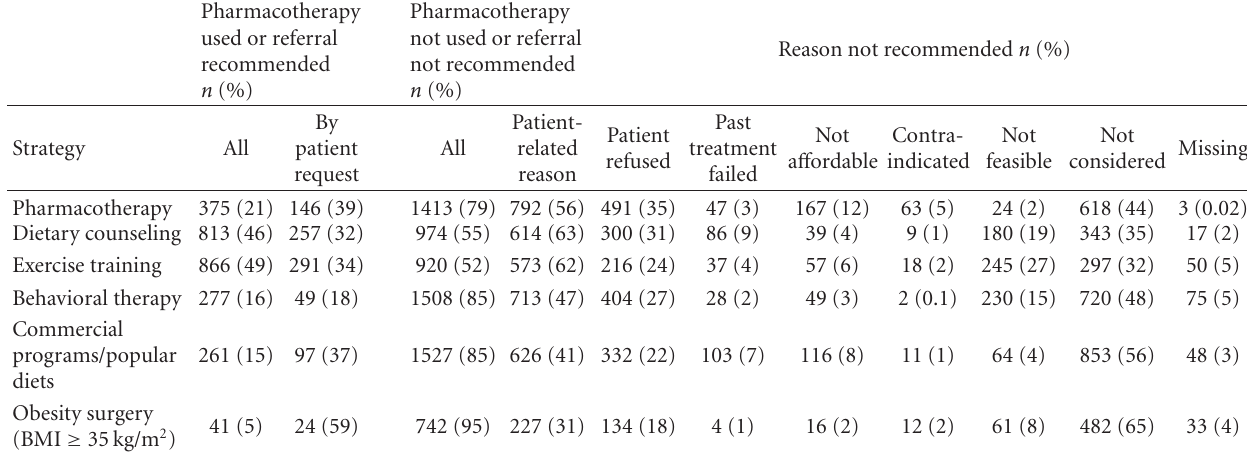
Table 2: Frequency of use of pharmacotherapy or referral for antiobesity management expertise.